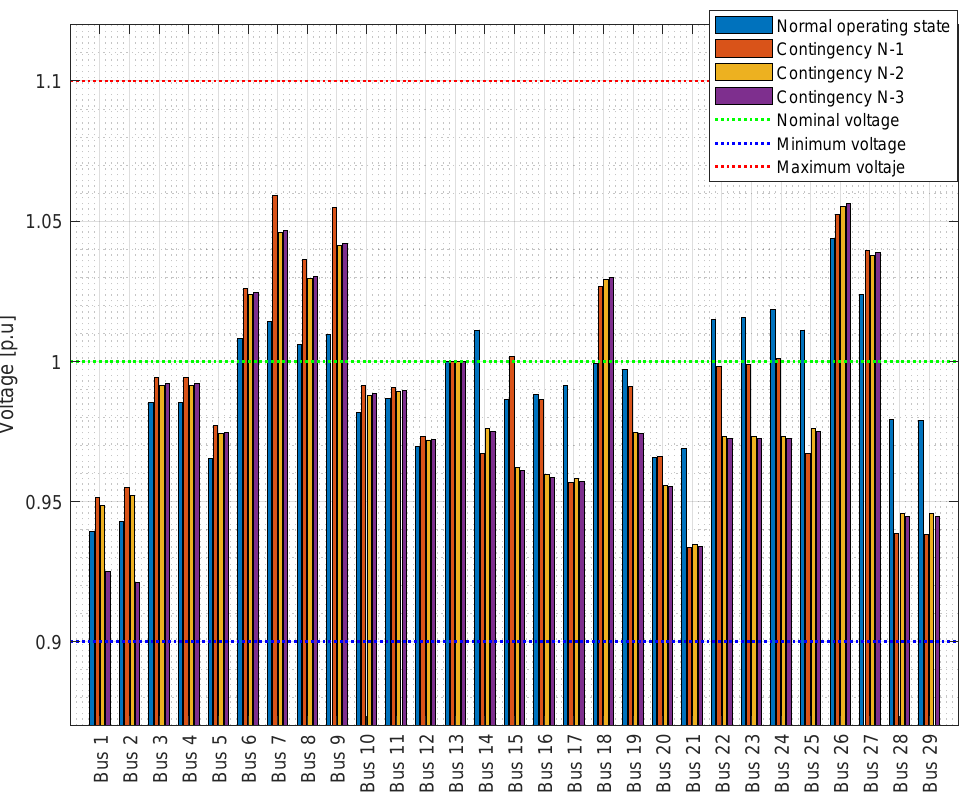
Figure 3. Voltage